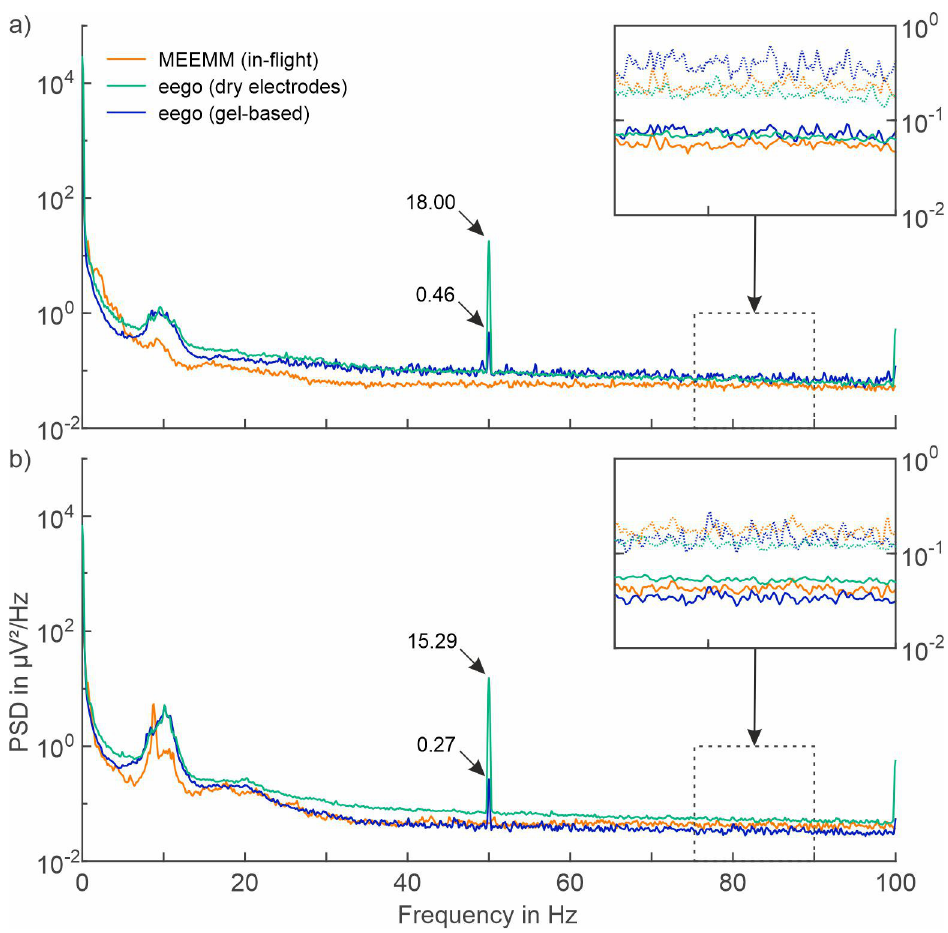
Fig 4. Comparison of power spectral density (PSD) between gel-based and dry EEG recordings. Average PSDs of 30 seconds of resting-state EEG data recorded with unshielded (MEEMM, in-flight), and actively shielded gel-based and dry electrode caps (eego, ground-level) conditions with a) open eyes, and b) closed eyes of the participants. Solid lines represent mean; dotted lines represent mean + standard